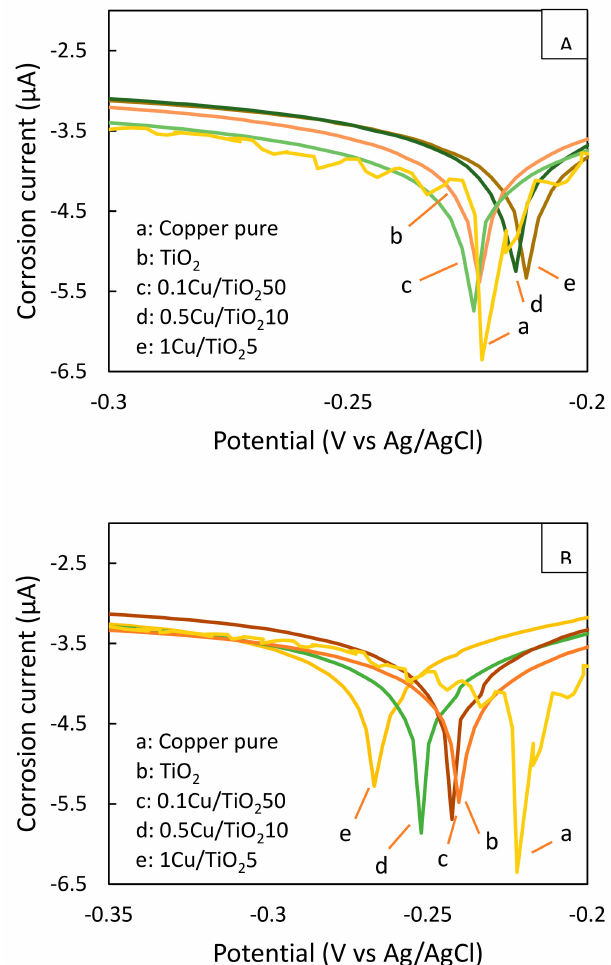
Figure 7. Polarization curves of copper terminal lug coated with nanocomposite films ( A ) in the dark ( B ) under UV irradiation at 1 mW / cm 2